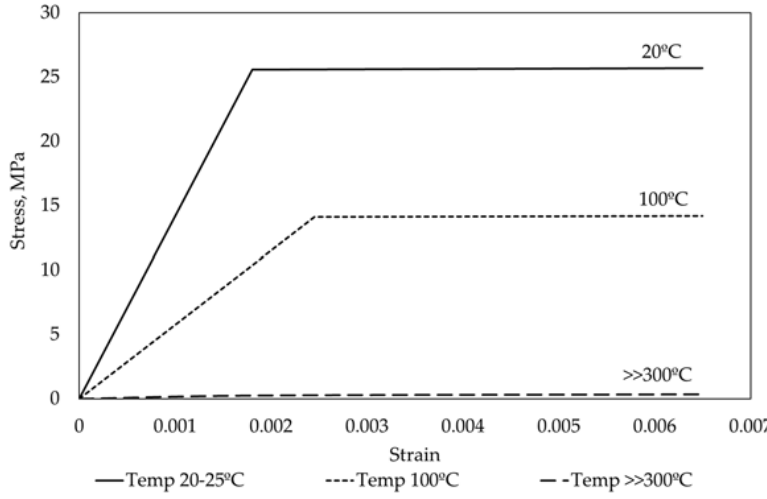
Figure 5. Strain–stress of GL32H wood at elevated temperatures.